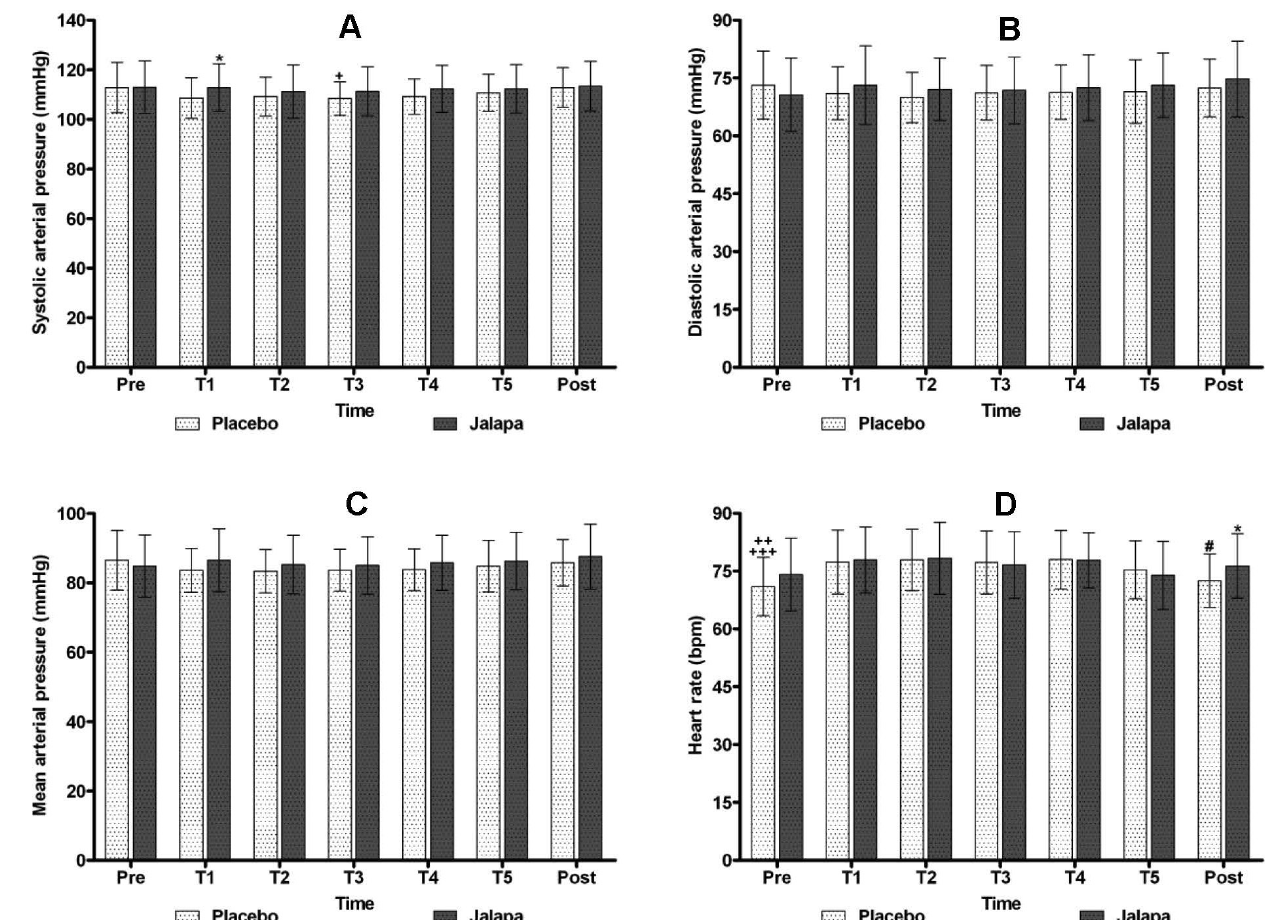
FIGURE 1 - SAP, DAP, MAP and HR of the placebo and jalapa groups in the pre-treatment, treatment and post-treatment. A - *P=0.04: In T1 SAP of jalapa group > placebo group. + P<0.05: In T3, PAS of placebo group < pre-treatment and post-treatment. B and C - No statistically significant differences (P>0.05) were found between the two groups and evaluated times. D - *P=0.03: and T2, T4 ( +++ P<0.001); # P<0.05: HR of the post-treatment in the placebo group < T2 and